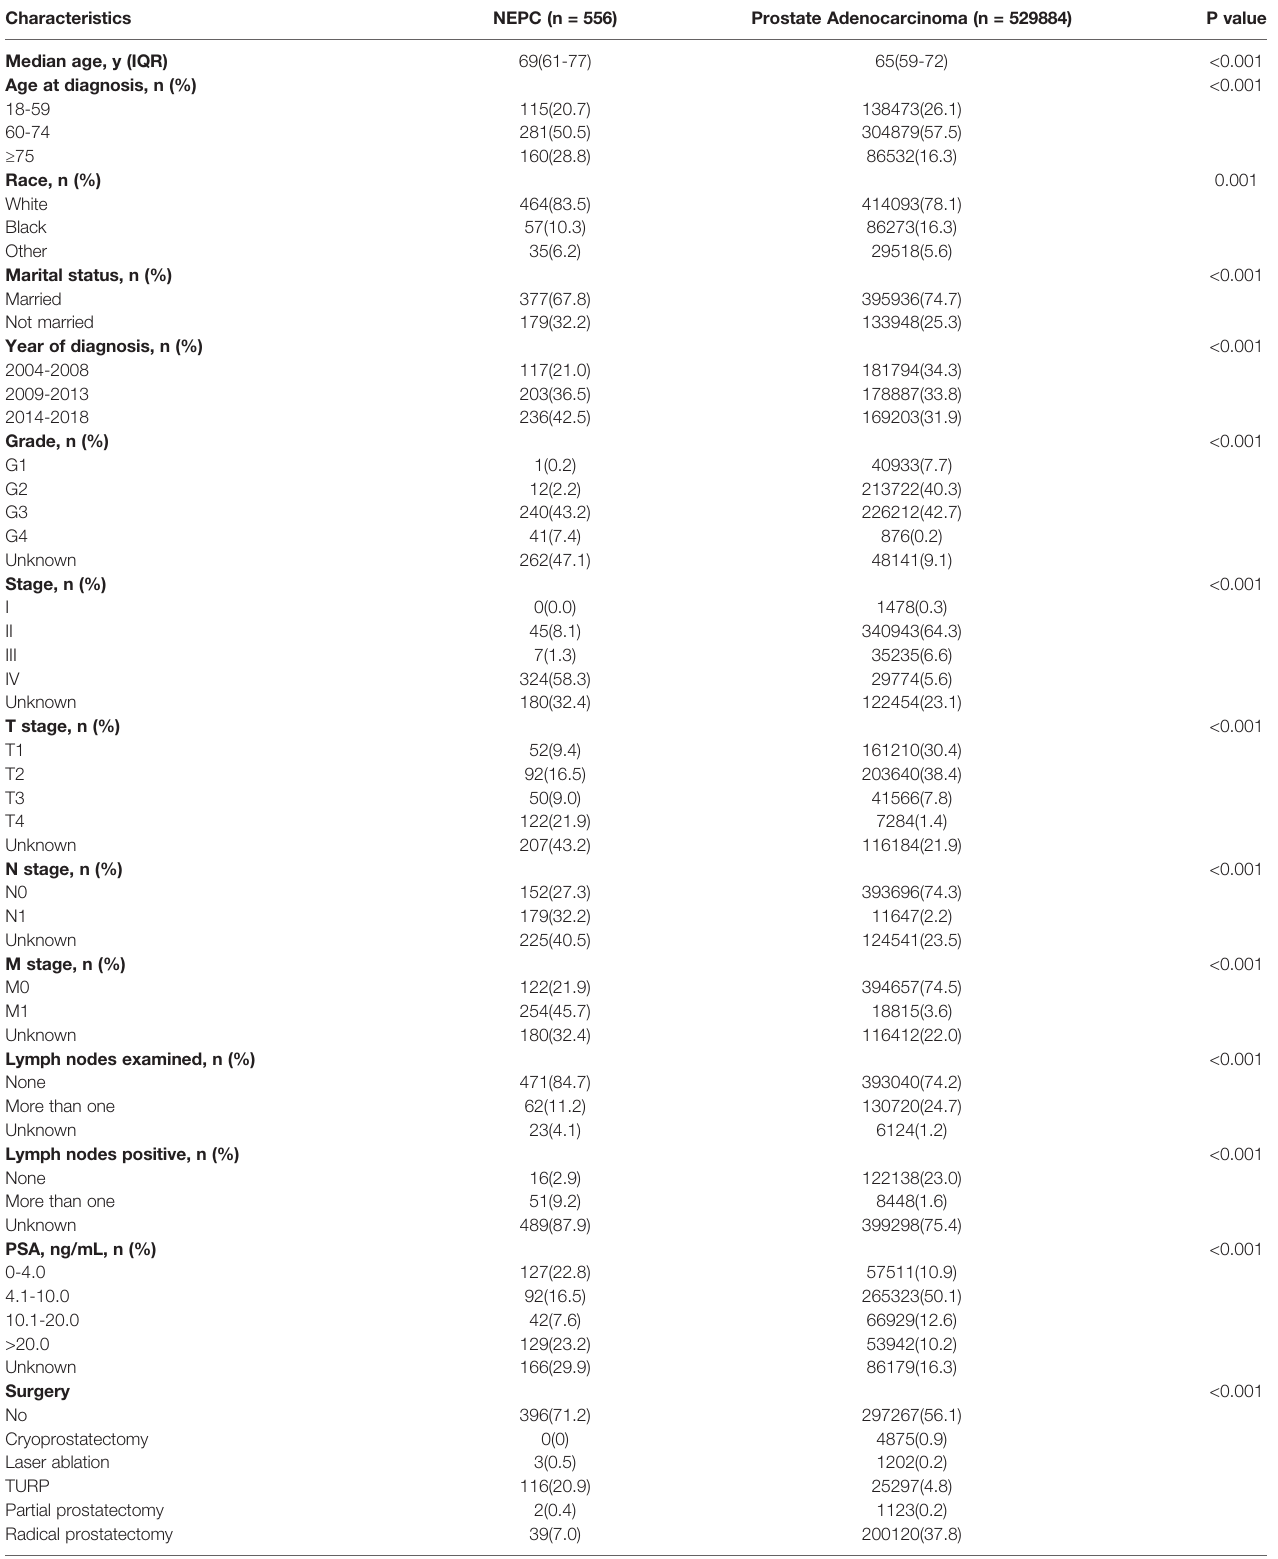
TABLE 1 | Baseline demographic and clinicopathologic characteristics of patients with prostate adenocarcinoma compare to NEPC.